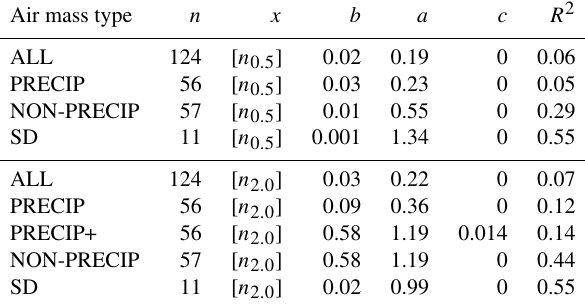
Table 1. Equations of the functions shown in Fig. 3 (i.e. PRE- CIP, PRECIP+, NON-PRECIP, SD) predicting cumulative concen- trations of ice-nucleating particles active at − 15 ◦ C [INP − 15 ] based on aerosol particles with aerodynamic diameters > 0.5µm [ n 0 . 5 ] and > 2.0µm [ n 2 . 0 ] along with their respective R 2 values. In addi- tion, equations and R 2 values of power functions fitted to all data points irrespective of air mass classes are shown (ALL). The equa- tions are listed based on the following formula: y = b · x a + c , with y equal to [INP − 15